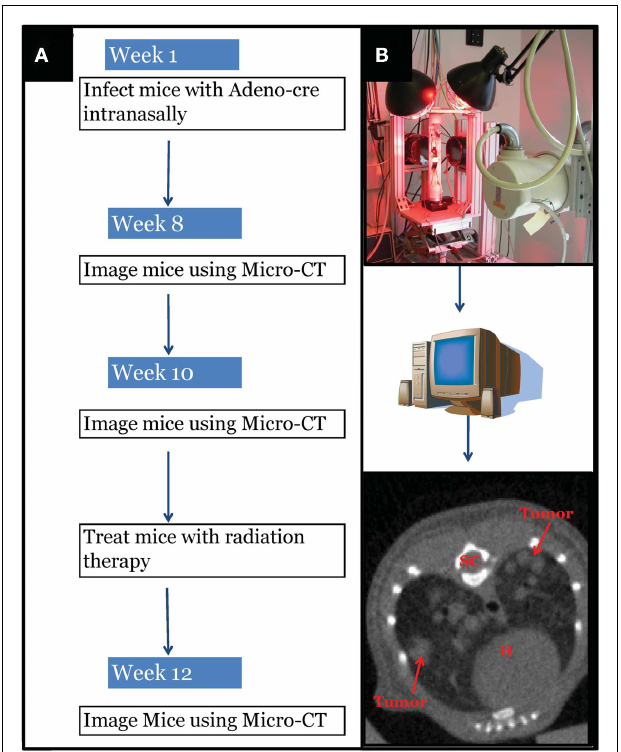
FIGURE 1 | Experimental design schematic. (A) At around 42days of age, mice with differing genotypes are infected with an adenovirus expressing Cre-recombinase (Adeno-Cre) via intranasal inhalation. Eight weeks after infection mice develop tumors large enough to be visible by micro-CT imaging. Mice are imaged again at 10weeks after Adeno-Cre infection to ensure appropriate identification of tumors with growth kinetics suggestive of lung adenocarcinoma. Immediately after a second micro-CT scan, mice undergo whole thorax irradiation with differing treatment regimens.Two weeks after radiation treatment mice are imaged again to evaluate tumor growth delay following radiation treatment. [ (B) Top Panel] Image of custom built Micro-CT scanner developed at the Duke Center for In vivo Microscopy with isotropic resolution of 88 µ . [ (B) Bottom Panel] Reconstructed image series were utilized to contour tumors to calculate gross tumor volumes and monitor relative growth kinetics. SC, spinal cord; H, heart.